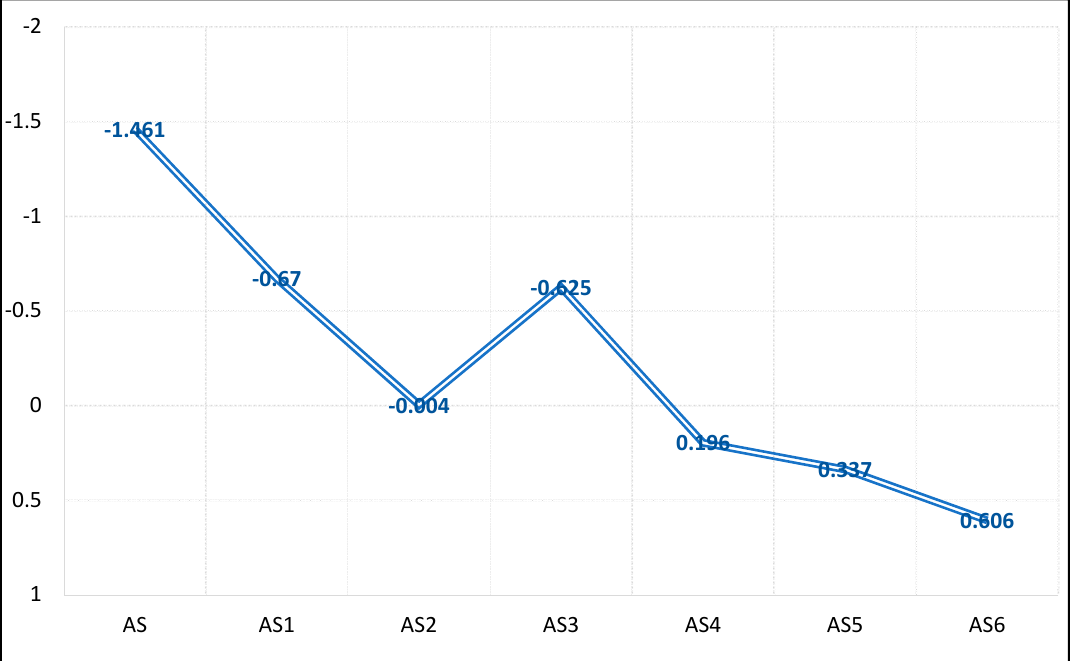
Figure 4. Penetration (0.1 mm) of PW and ULO-modified asphalt pastes. Table 6. Temperature sweep of PW and ULO-modified asphalt